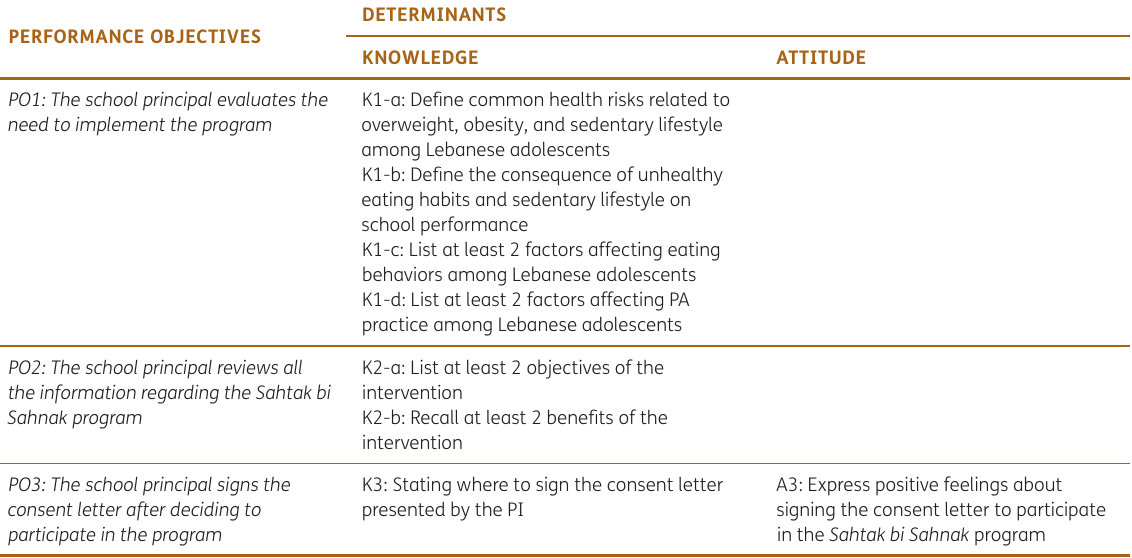
Table 3 Program use outcomes, performance objectives, and change objectives for